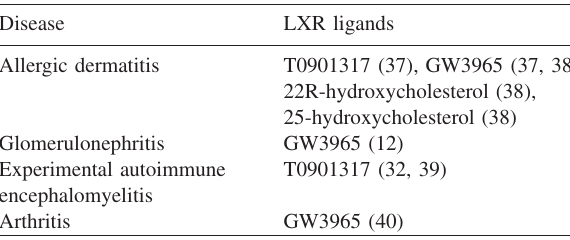
Table 2 Inhibitory effects of LXR agonists on immune